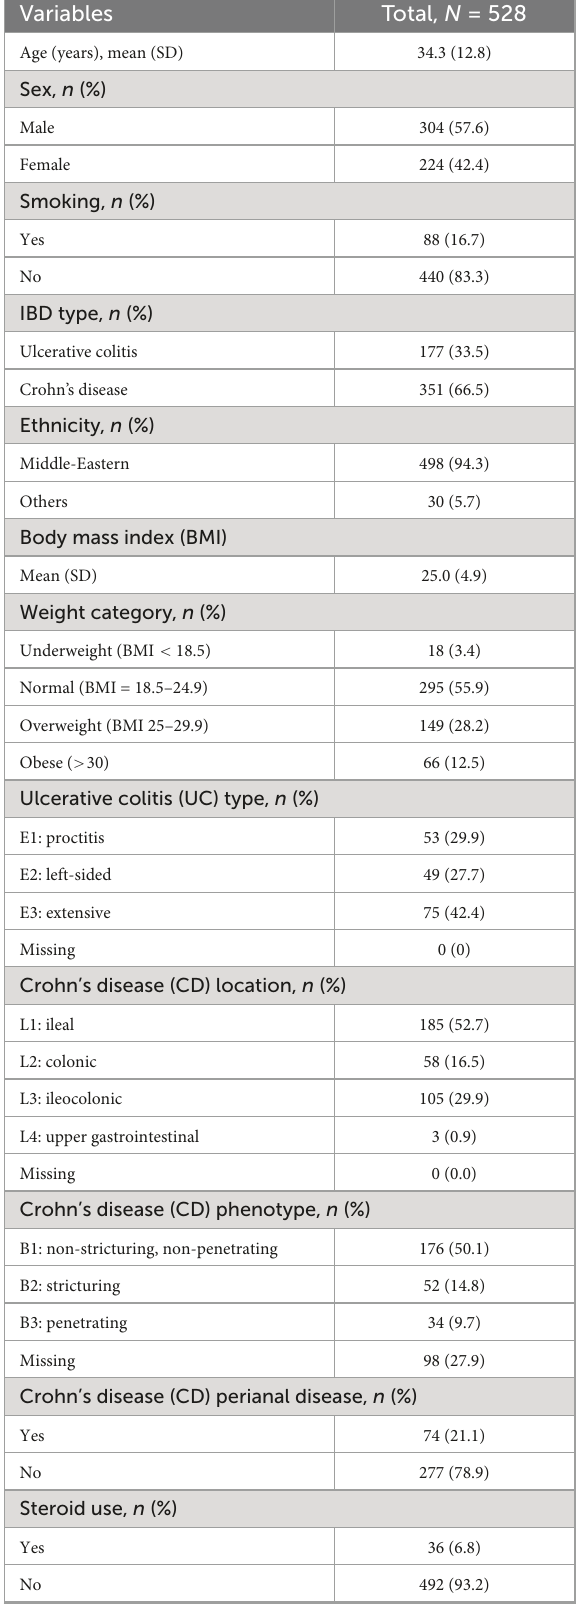
TABLE 1 Baseline characteristics of the entire